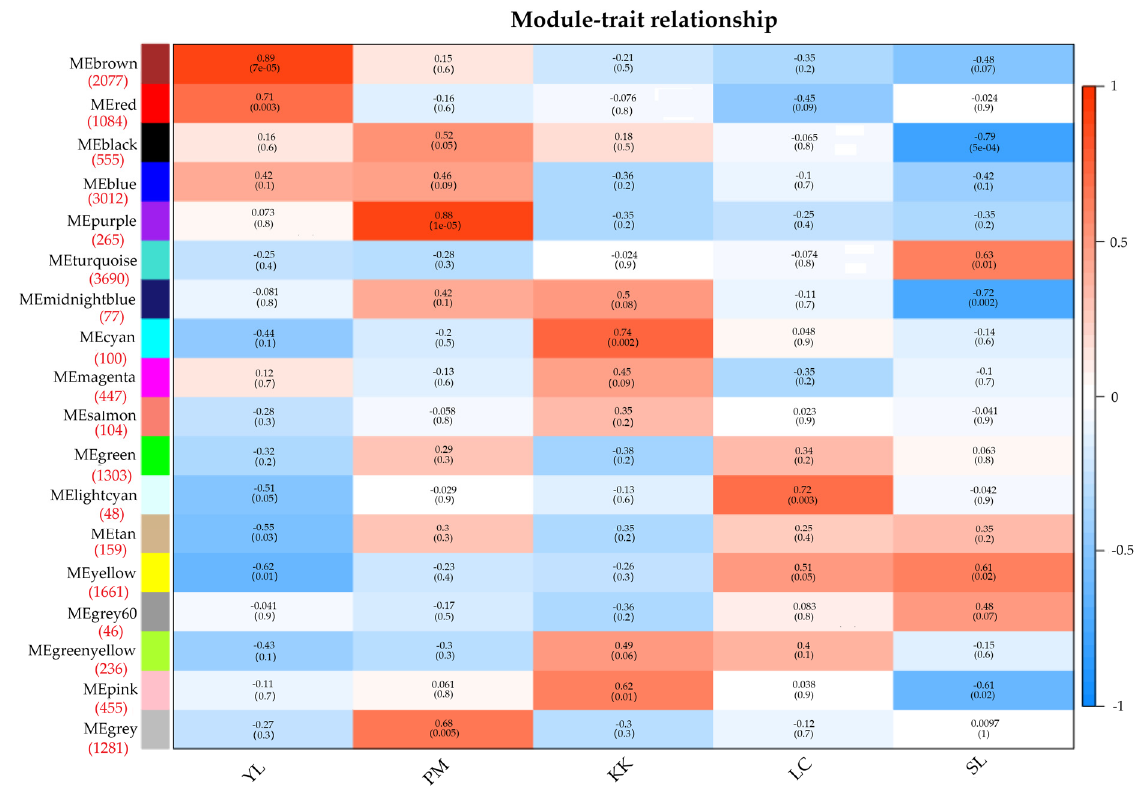
Figure 7. The module-sample relationships. The x -axis represents different groups, the y -axis represents the name of each module, the number under the module name represents the number of genes in the corresponding module. Each cell contains the corresponding correlation and p -value, red for positive correlation and blue for negative correlation.